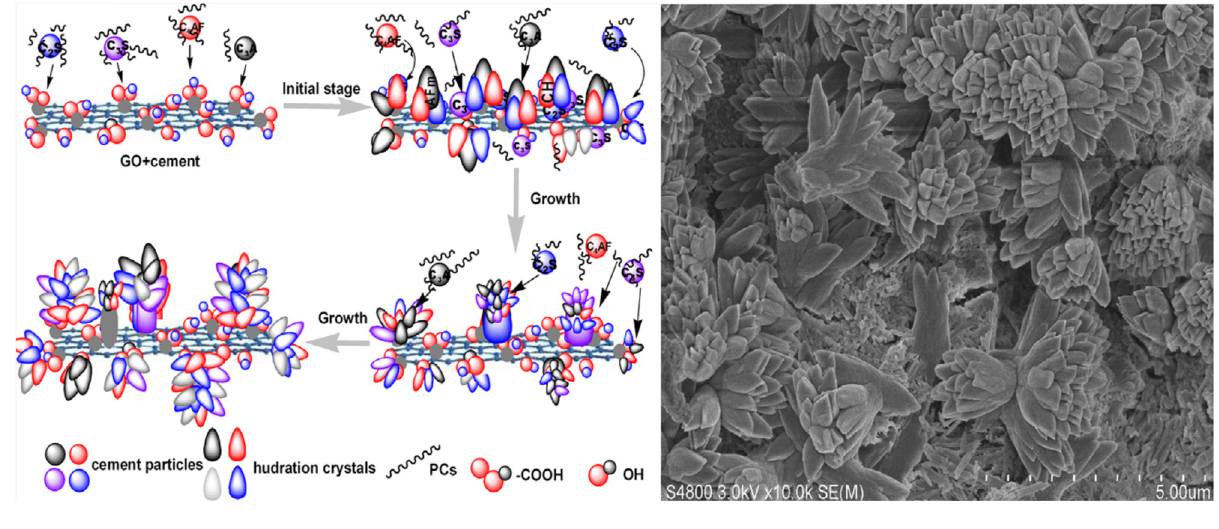
Figure 8: Template e ff ect of GO and fl ower - like crystals [ 49 ] .